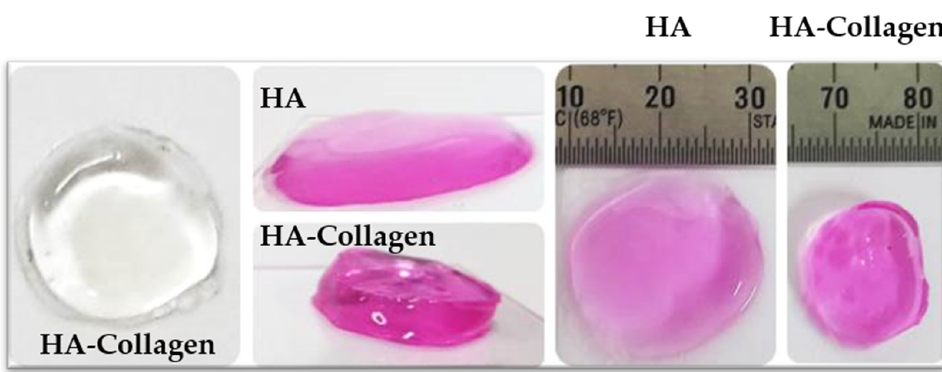
Figure 4. Optical images of HA-collagen hybrid gel and HA hydrogel. The mechanical integrity of HA-collagen hydrogel was increased compared with HA hydrogel. HA, hyaluronic acid.